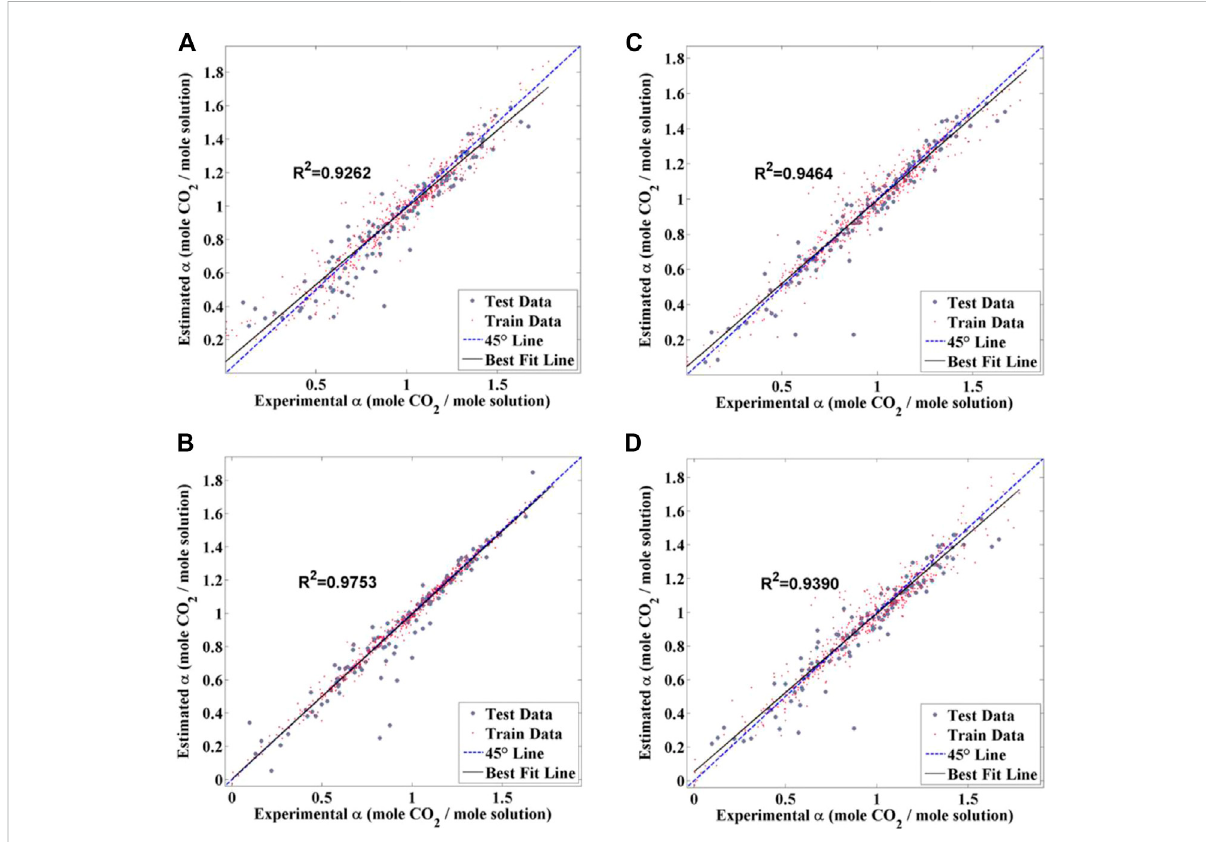
FIGURE 12 Regression plot for the absorption of CO 2 prognostication by (A) LSSVM, (B) RBF-NN, (C) PSO-ANFIS, and (D) ANFIS (Dashti et al.,